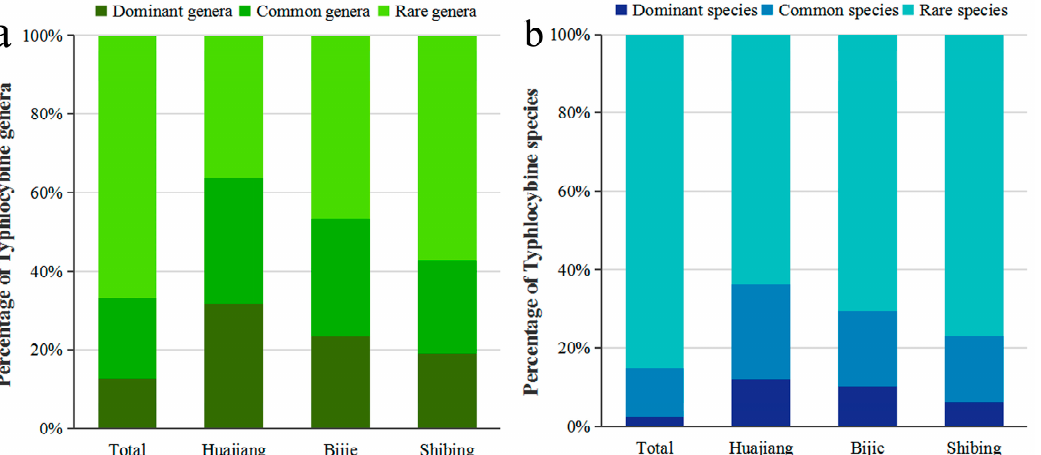
Figure 5. Percentage of genera and species of typhlocybine leafhoppers in different study areas (( a ): Percentage of Typhlocybine genera; ( b ): Percentage of Typhlocybine species).